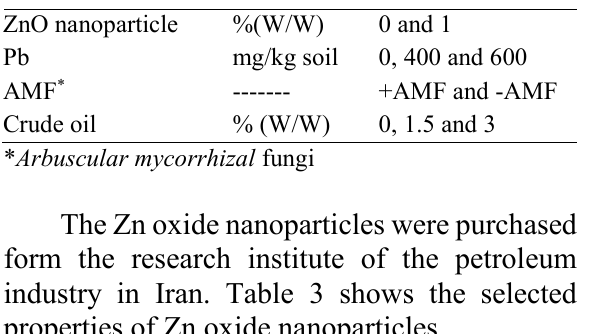
Table 2. Treatments used in experiments Treatments